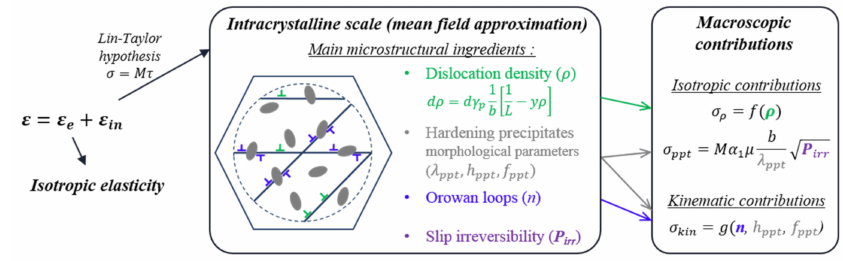
Figure 8. Global scheme for the proposed constitutive model.